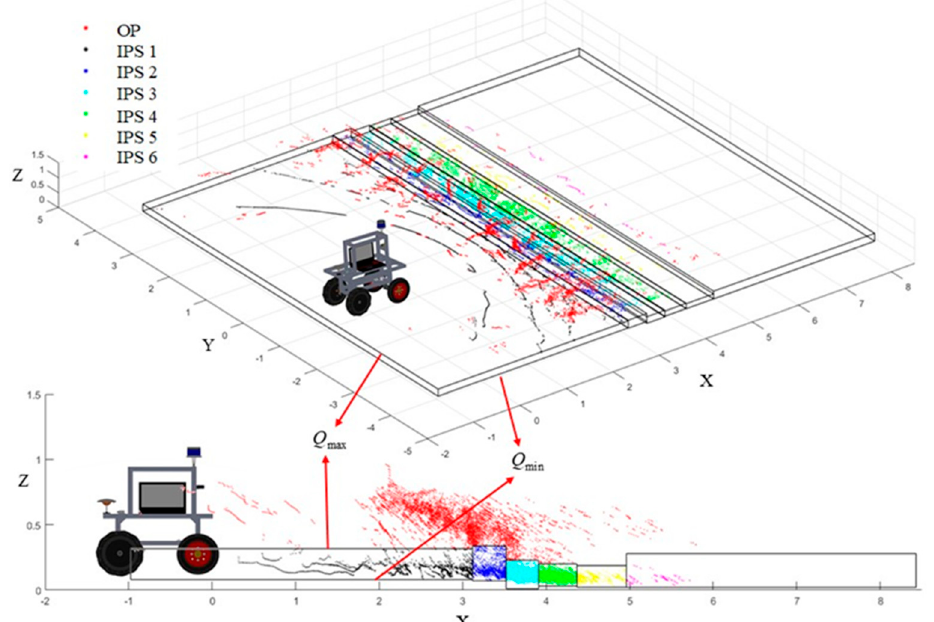
Figure 4. An example of the application of gating. The black bounding boxes indicate the gates. In the figure, “Outlier Points” is simply represented as OP, “Inlier Points of Slice n” is simply represented as IPS n. Inlier points in different regions are shown in different colors.